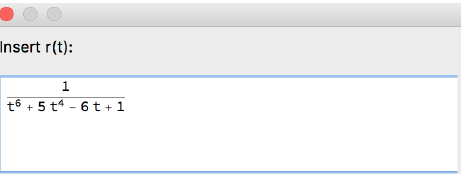
Figure 64. Part of the structure of the [SInt] 2.0 algorithm responsible for the input